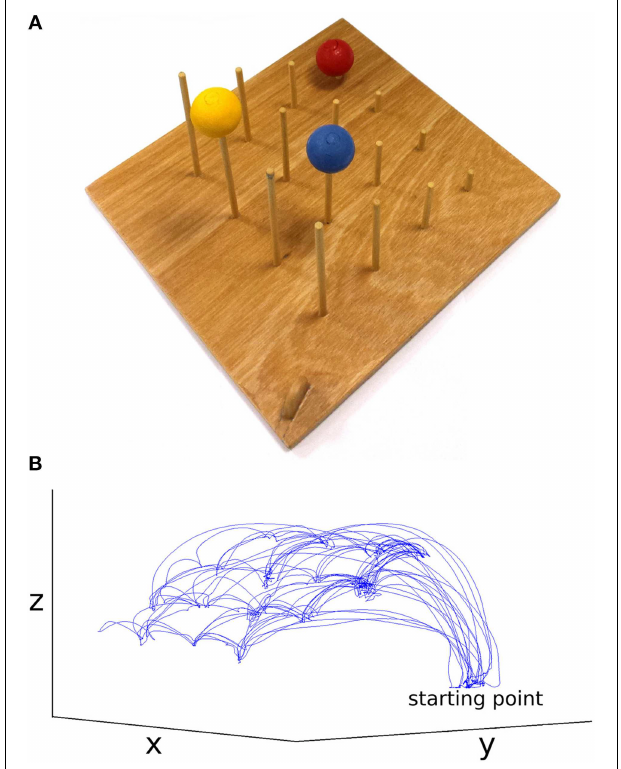
FIGURE 1 | (A) Imitation game apparatus, starting point center bottom, (B) example dataset, movement of the thumb in x, y, and z for the face-to-face & simple condition (not to